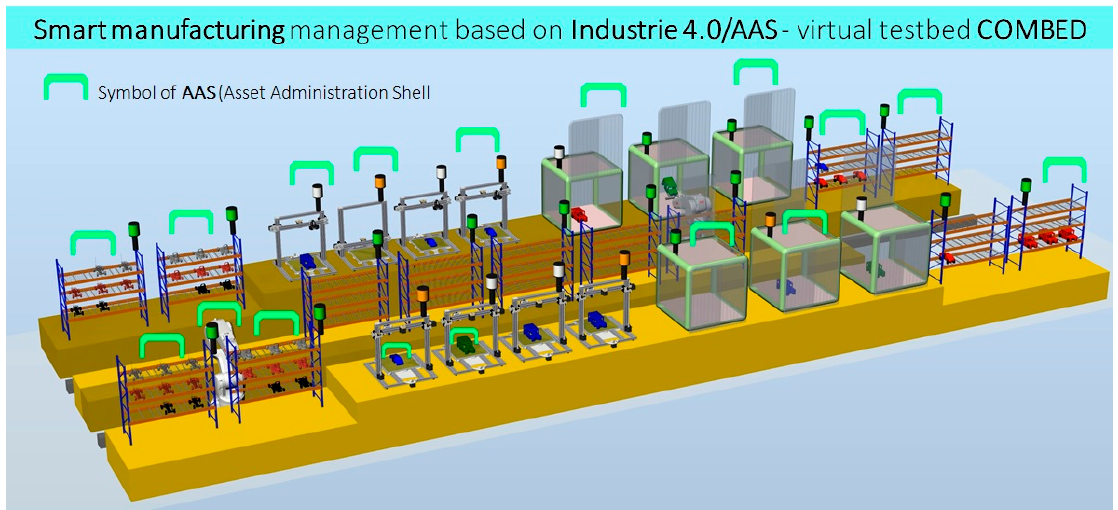
Figure 7. The virtual production segment (COMBED) introduced at the 2019 International Engineering Fair in Brno, the Czech Republic.